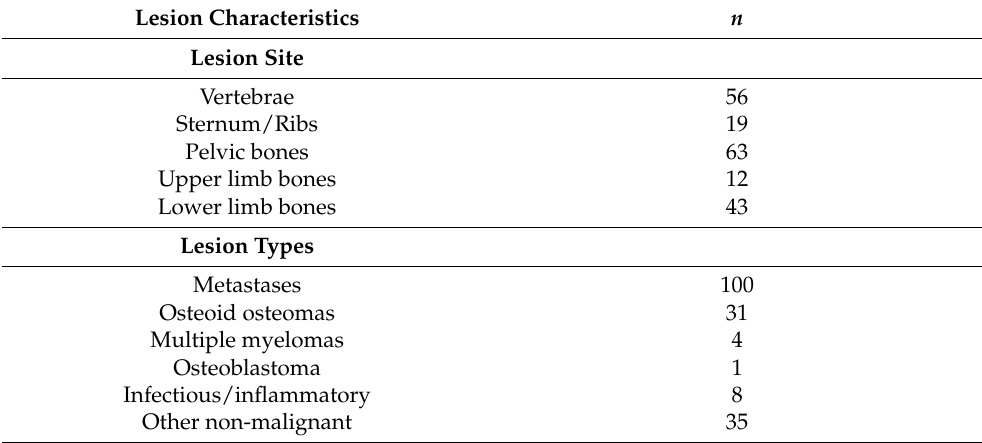
Table 2. Lesion characteristics including site and histotypes.